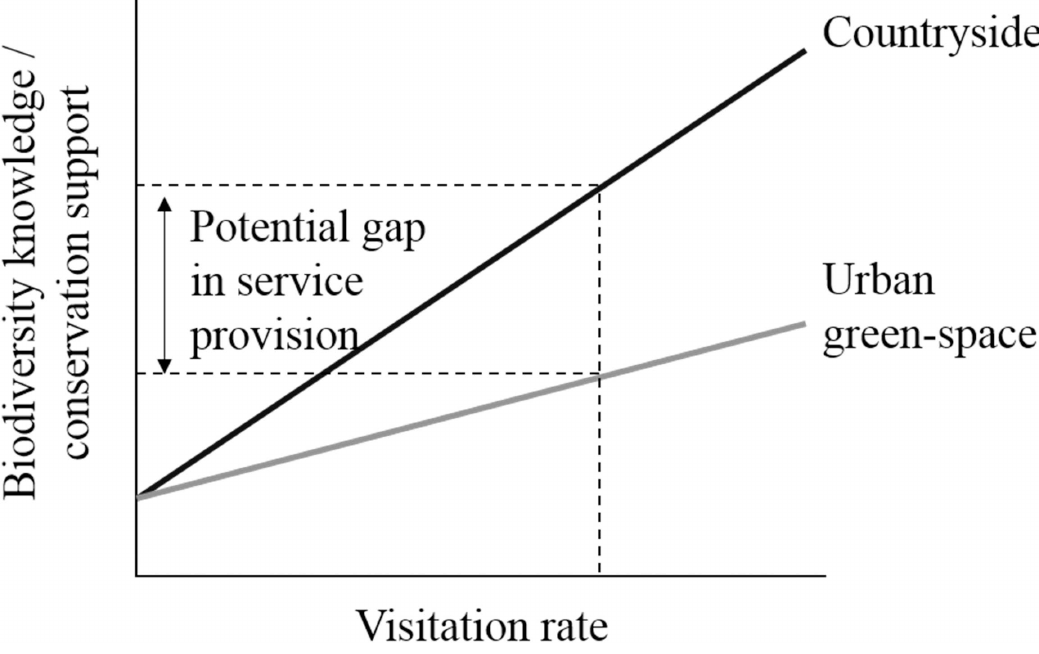
Fig 1. Potential ecosystem serviceprovision gap between urban and rural green-spaces. The slopes of the relationshipsbetweengreen-spacevisitationrate and biodiversity knowledge(i.e. educationalecosystem services) and associatedsupport for conservation may be shallowerfor visits to urban than rural green-space,generatinga gap in provisionof educationalecosystemservices betweenurban and rural green-space. This divergence in service provision may arise from exposureto less diversebiotic assemblagesin urban areas that typically comprise generalistspecies of limited conservation concern.